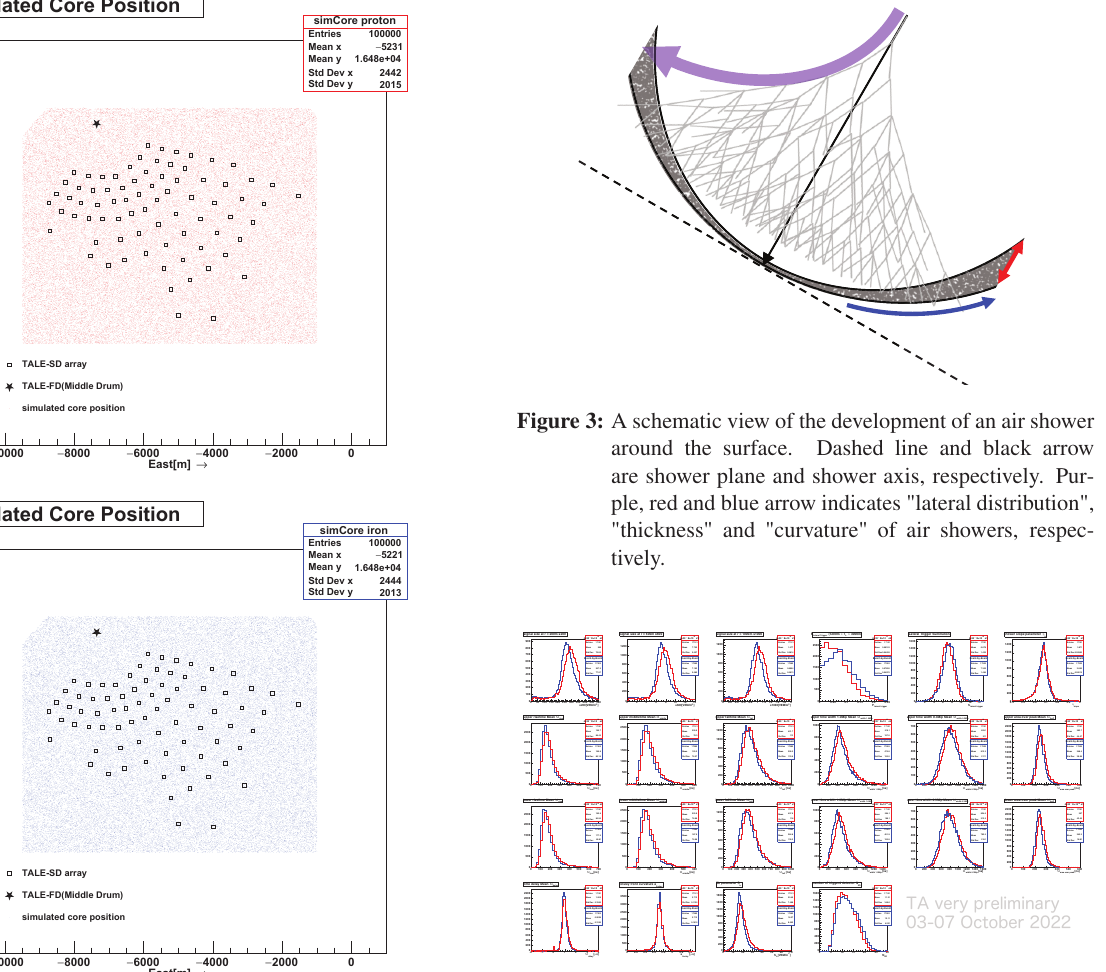
Figure 2: Simulated core position distribution for TALE-SD ar- ray. (cid:3) , (cid:7) and • / • indicates TALE-SD array, TALE-FD and simulated core positions, respectively. red one is (a)proton and blue one is (b)iron. "Entries" indicates the number of generated events.